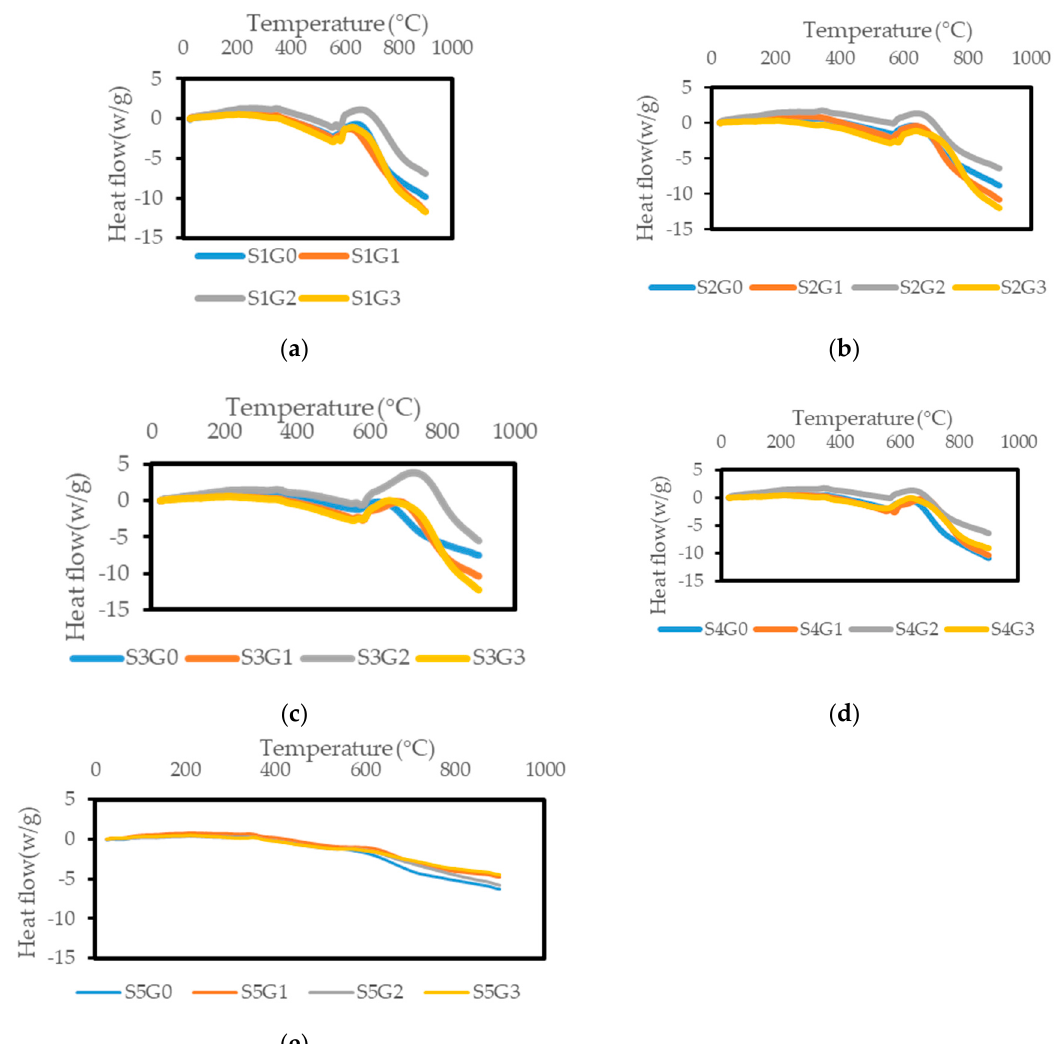
Figure 6. Effect of GNP on the differential scanning calorimetry (DSC) plots of laminated composites. Figure 6. E ff ect of GNP on the di ff erential scanning calorimetry (DSC) plots of laminated composites. ( a ) S1, ( b ) S2, ( c ) S3, ( d ) S4, ( e ) S5. ( a ) S1, ( b ) S2, ( c ) S3, ( d ) S4, ( e )